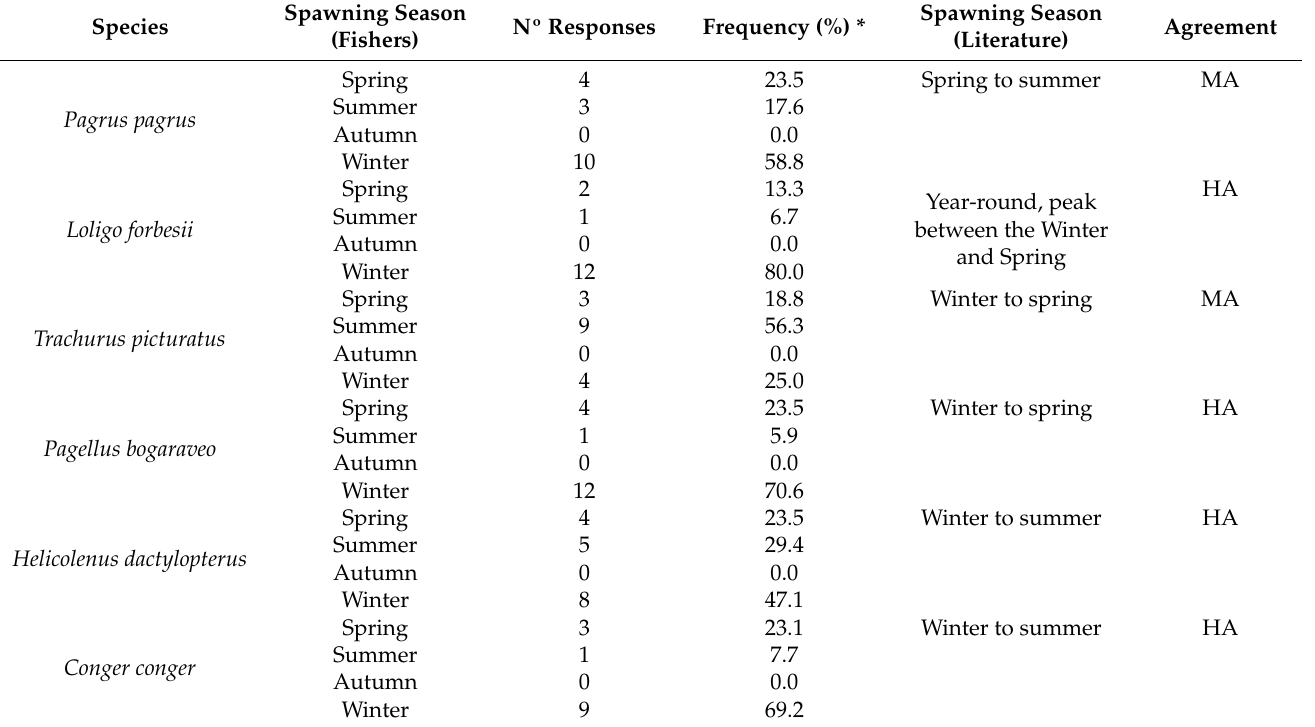
Table 1. Spawning season of the six species studied in the Azores according to fishers’ experiential knowledge, obtained from scientific literature [32], and the agreement between these two sources of information. MA = medium agreement; HA = high agreement. Nº responses = number of fishers who answered this item.